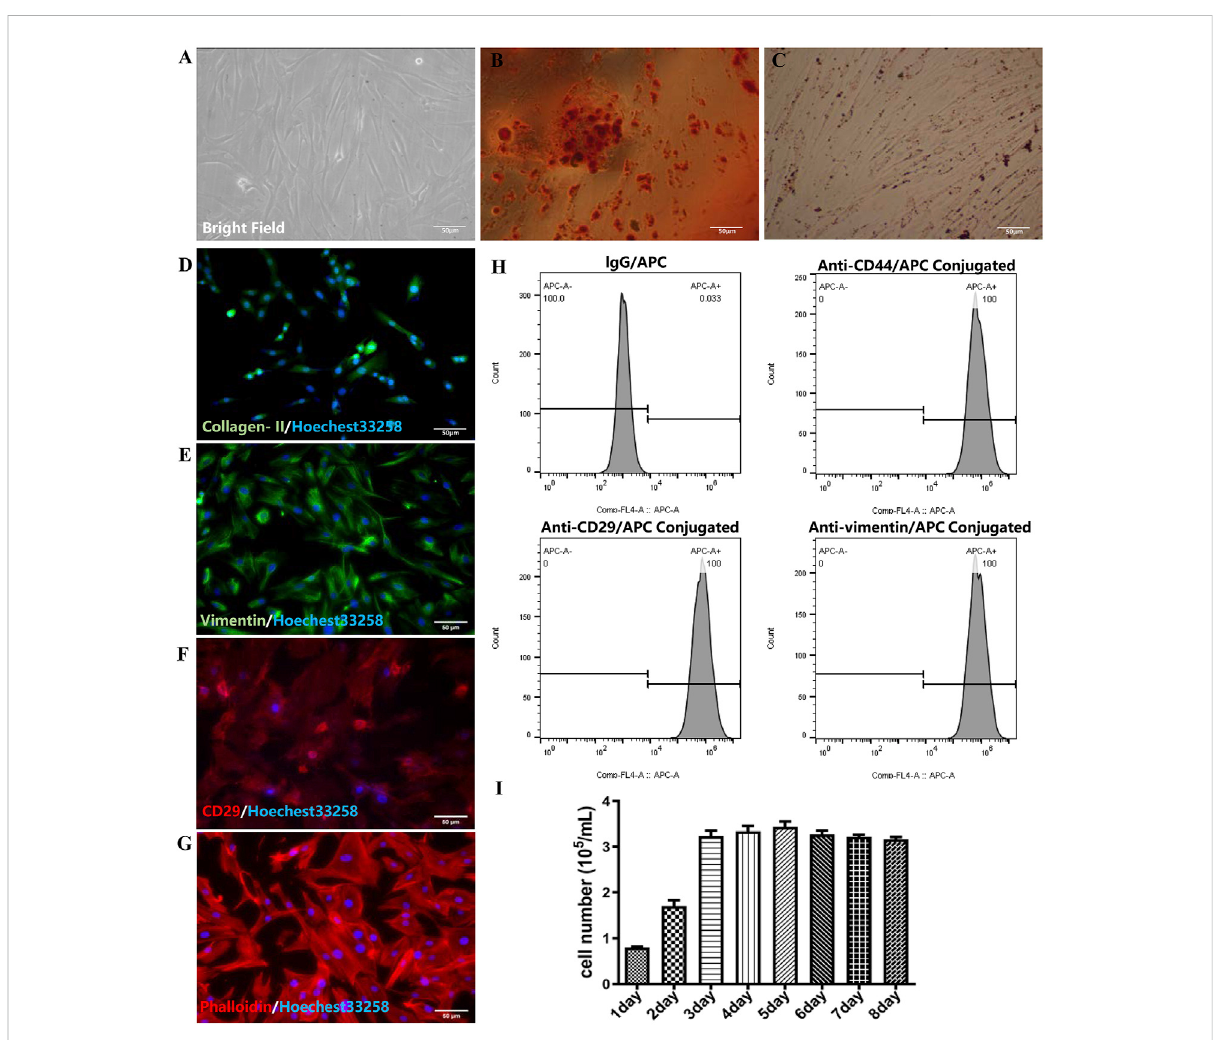
FIGURE 1 Identi fi cation of RMSC (scar = 50 μ m). (A) Bright fi eld image of RMSCs; (B) Adipogenic RMSCs were stained with Oil Red O; (C) Alizarin Red staining of osteogenic RMSCs; (D) collagen II immuno fl uorescence of chondrogenic RMSC; (E) Immuno fl uorescence staining of vimentin; (F) Immuno fl uorescence staining of CD29; (G) Immuno fl uorescence staining of phalloidin; (H) The fl ow-cytometry analysis of CD44, CD29, and vimentin; (I) The growth bar graph curve of